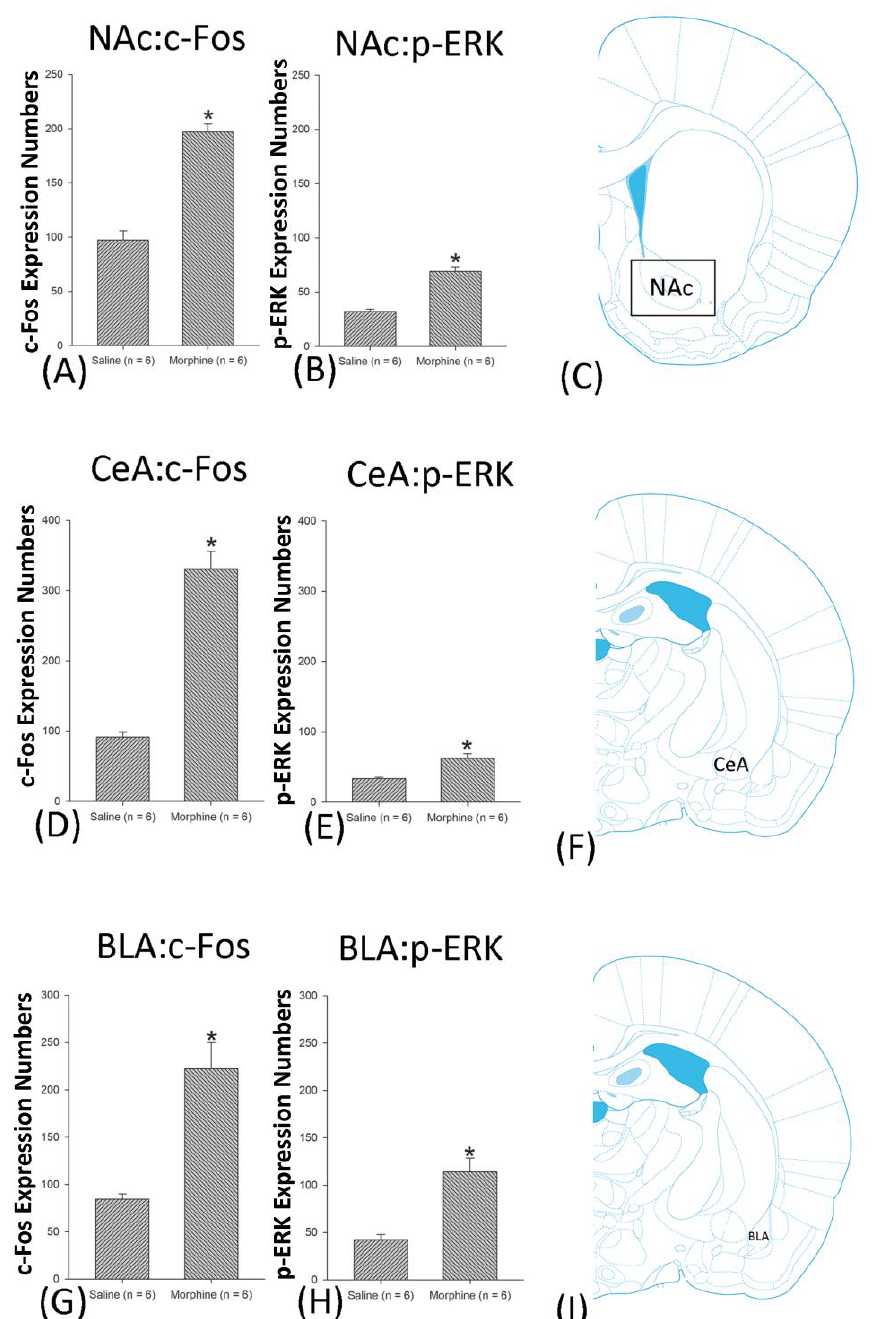
Figure 15. c-Fos or p-ERK expression occurred in the nucleus accumbens (NAc), central amygdala (CeA), and basolateral amygdala (BLA) in reinstatement. c-Fos expression, p-ERK expression, respectively, in the NAc ( A , B ), in LH ( D , E ), and in PC ( G , H ). ( C , F , I ) indicate a schematic representation of the NAc, CeA, and BLA. * p < 0.05 when comparing the saline and morphine groups ( n = 6 per group).